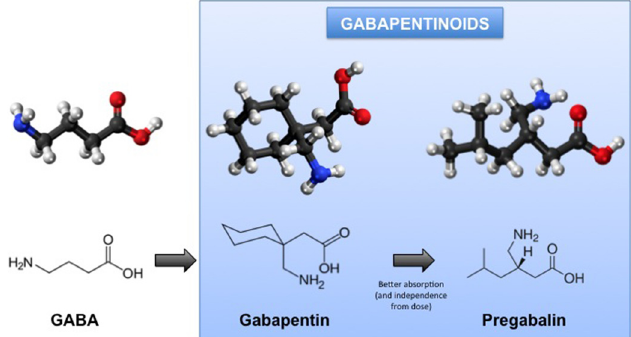
Figure 1. Chemical structure of gabapentinoids. The evolution of their chemical structure from GABA is shown (black arrows). (All images are of public domain or under creative commons license CC BY- SA 4.0.)